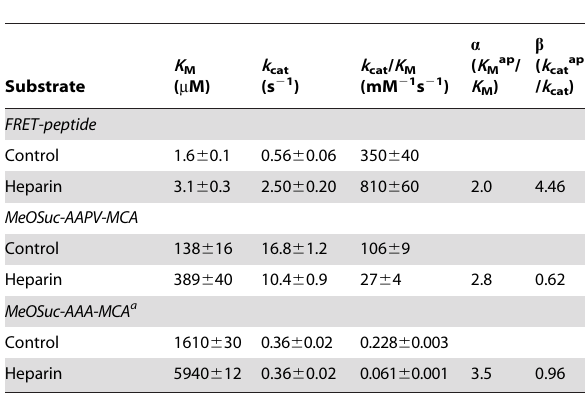
Table 1. Steady-state kinetic parameters for hydrolysis of fluorogenic substrates by human neutrophil elastase in the presence of